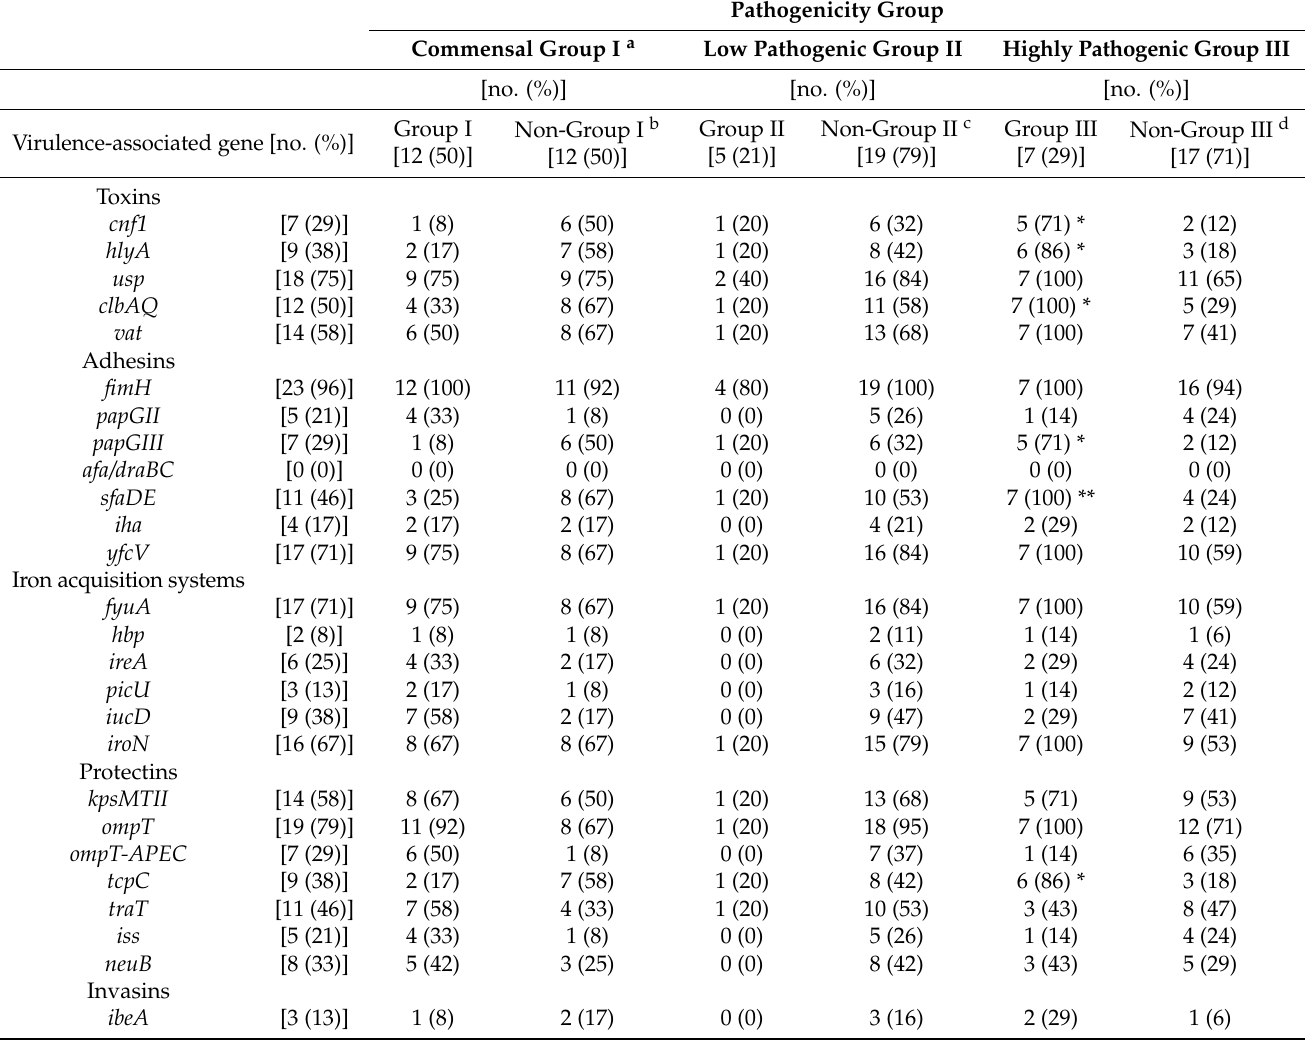
Table 2. Distribution of virulence-associated genes among E. coli strain pathogenicity groups. Statisti- cal analysis was performed on a set of 24 strains (10 human E. coli strains isolated from patients with urinary tract infection, 10 E. coli strains isolated from fecal samples of healthy individuals, and a set of 4 control pathogenic and non-pathogenic